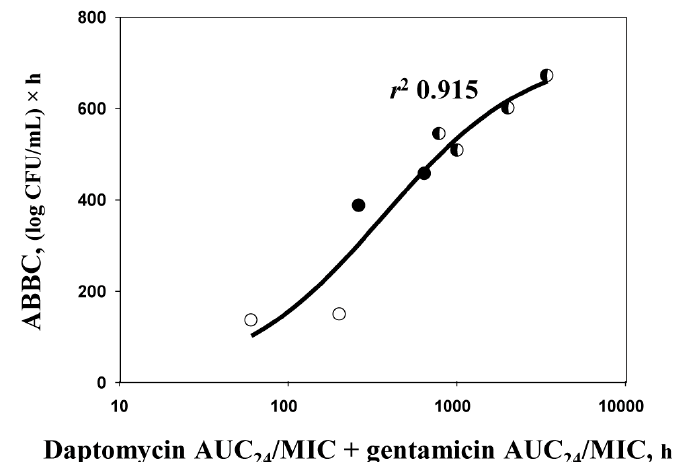
Figure 4. The sum of AUC 24 / MICs of daptomycin and gentamicin related to the ABBCs observed with S. aureus 293 in single treatments with daptomycin (open circles) or gentamicin (filled circles) and in combined treatments (half-filled circles). The relationships fit by Equation (1): Y 0 = 0, x 0 = 2.559, a = 728.9, b = 0.4316.